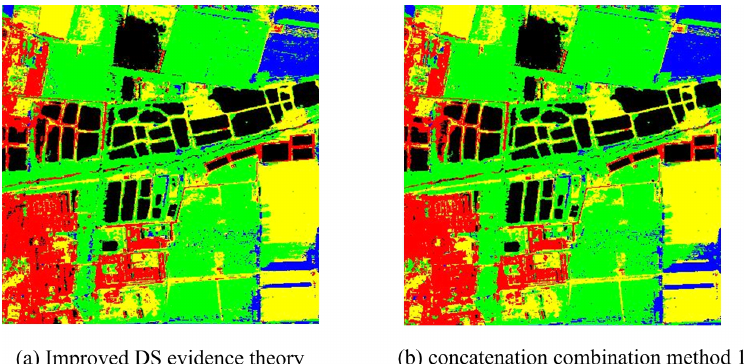
Figure 13. Classification result using parallel and concatenation combination